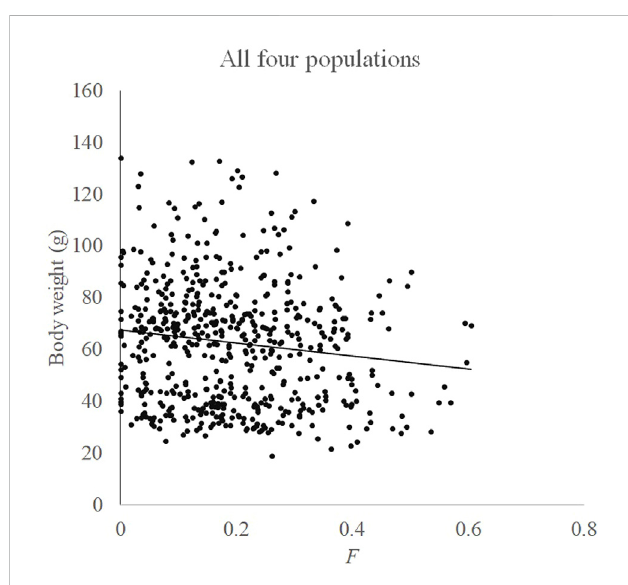
FIGURE 4 Relationship between F and body weight in all four